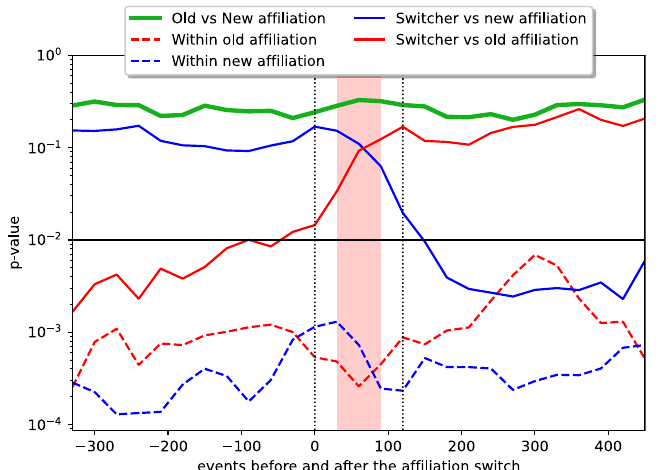
Figure 5. The statistical significance of parliament member voting similarities around affiliation-switching events. The highlighted area in the middle indicates the span where we cannot reject the null hypothesis about equal means with 0.01 statistical